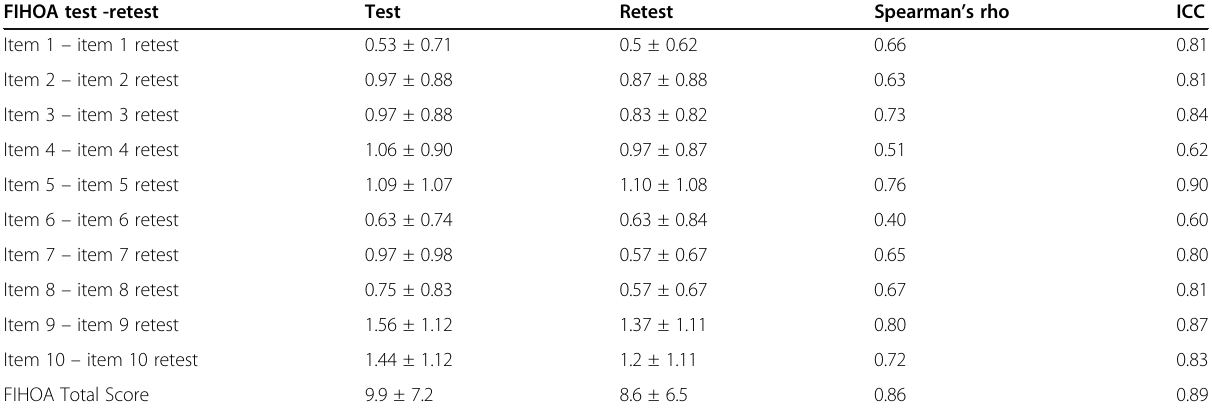
Table 3 Test-retest of reliability of the Brazilian version of the FIHOA questionnaire FIHOA test